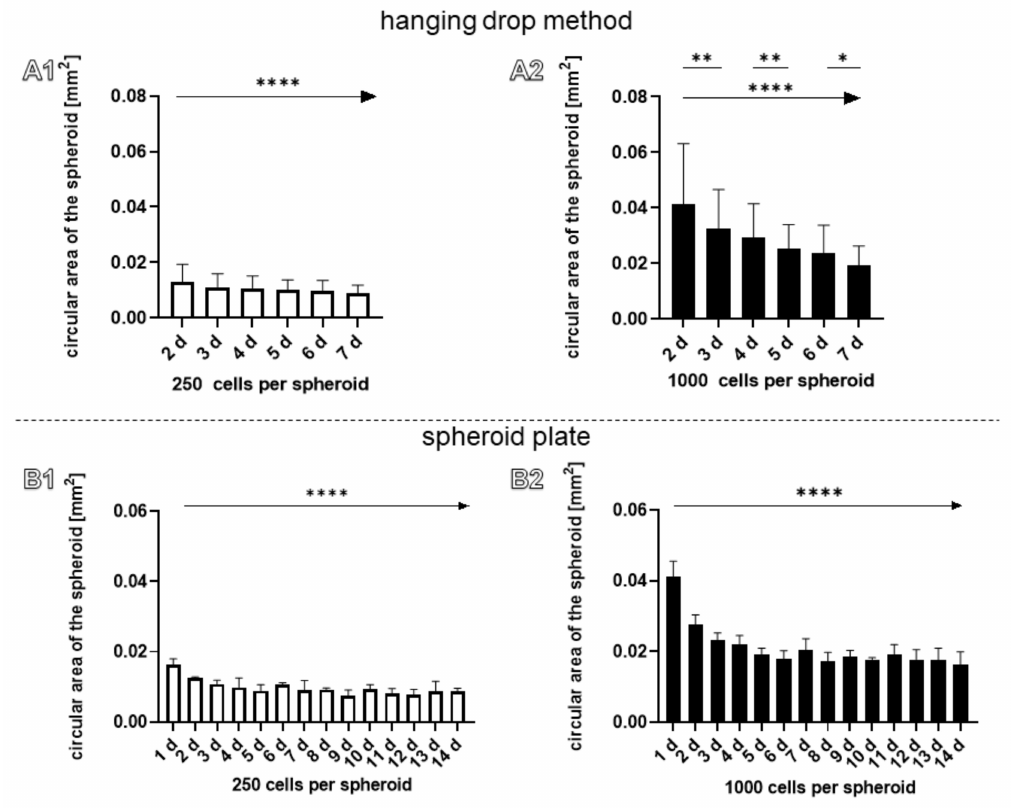
Figure 4. The circular surface area was measured in spheroids prepared either by the hanging-drop- ( A1 , A2 ) or spheroid-plate-based methods ( B1 , B2 ). ( A1 , B1 ) 250 cells per spheroid. ( A2 , B2 ) 1000 cells per spheroid. Statistics: n = 3 independent experiments were performed with cells of three different donors. One-way ANOVA (Tukey’s multiple comparisons test) for comparison between groups. Linear trend test (* → p values: * <0.05, ** <0.01, **** <0.0001 ( A1 – B2